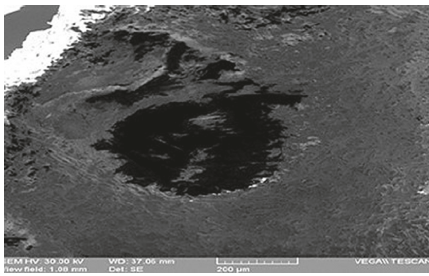
Figure 2: Palm kernel’s not reacted core SEM image (200 µ